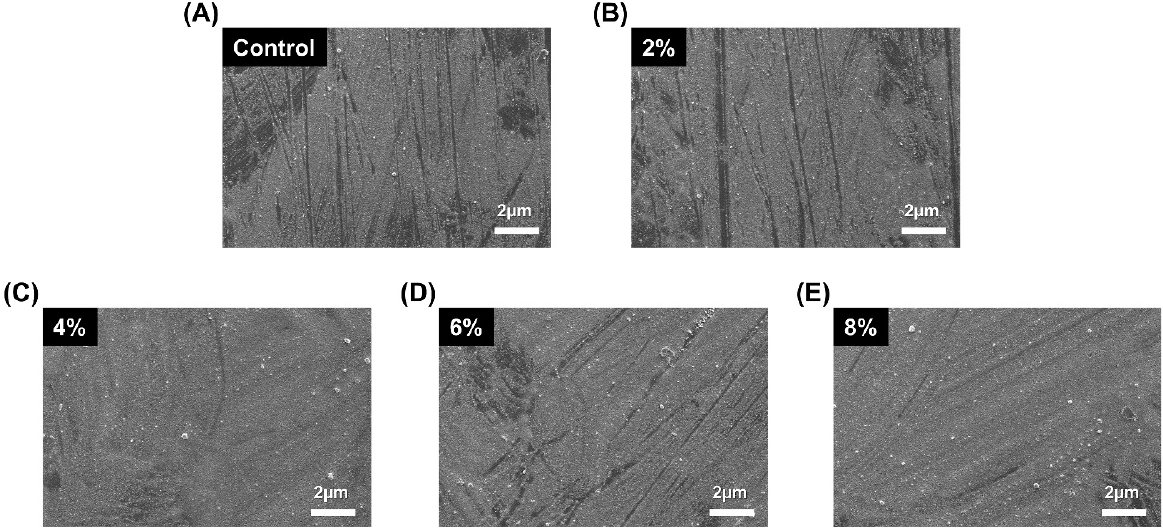
Figure 2. Representative SEM micrographs of the sample surfaces: ( A ) control, ( B ) 2%, ( C ) 4%, ( D ) 6%, ( E ) 8%. ( E )